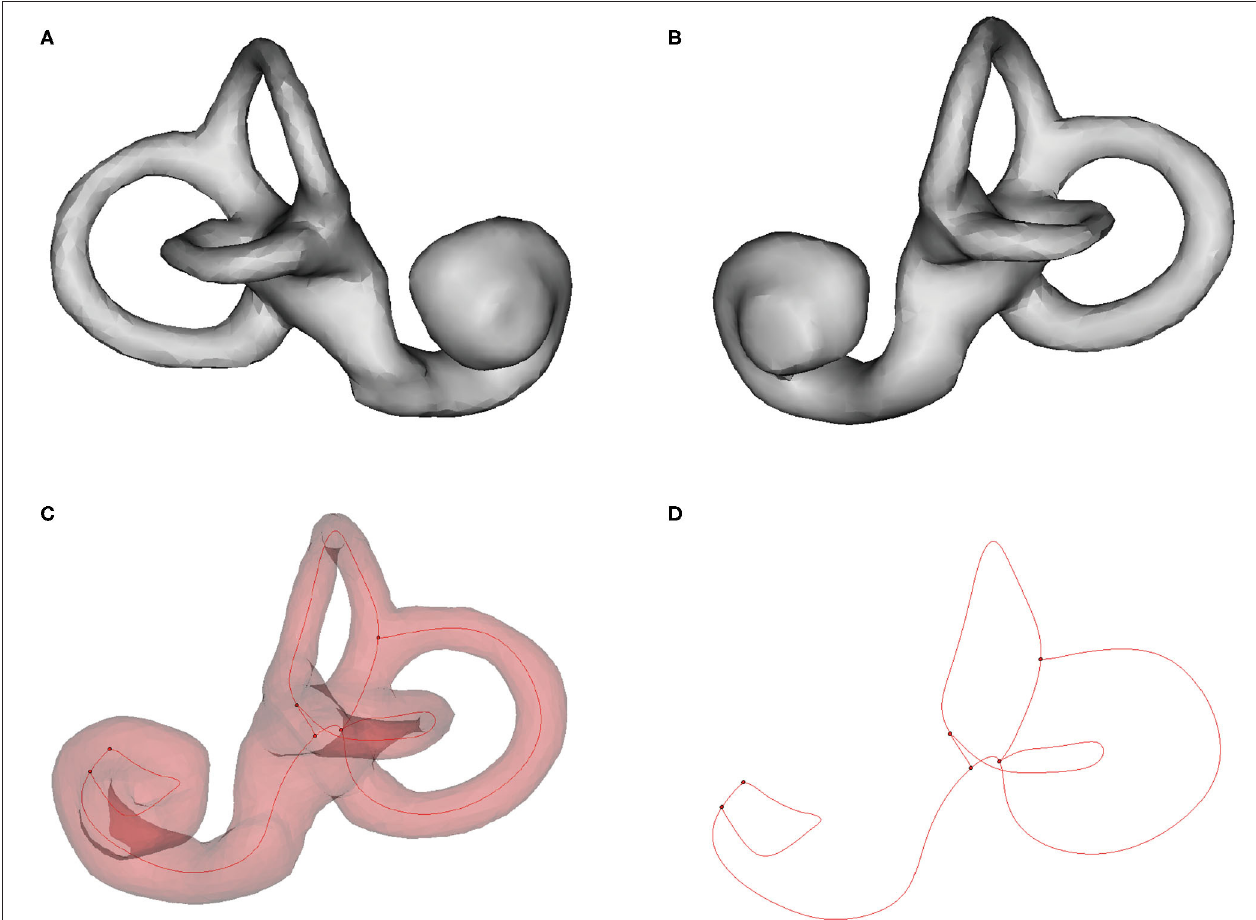
FIGURE 5 | Three-dimensional rendering of the cochlea and semicircular canals, and the centerline of the semicircular canals. (A) Left cochlea and semicircular canal. (B) Right cochlea and semicircular canal. (C, D) Centerline (red) of the right semicircular canal.